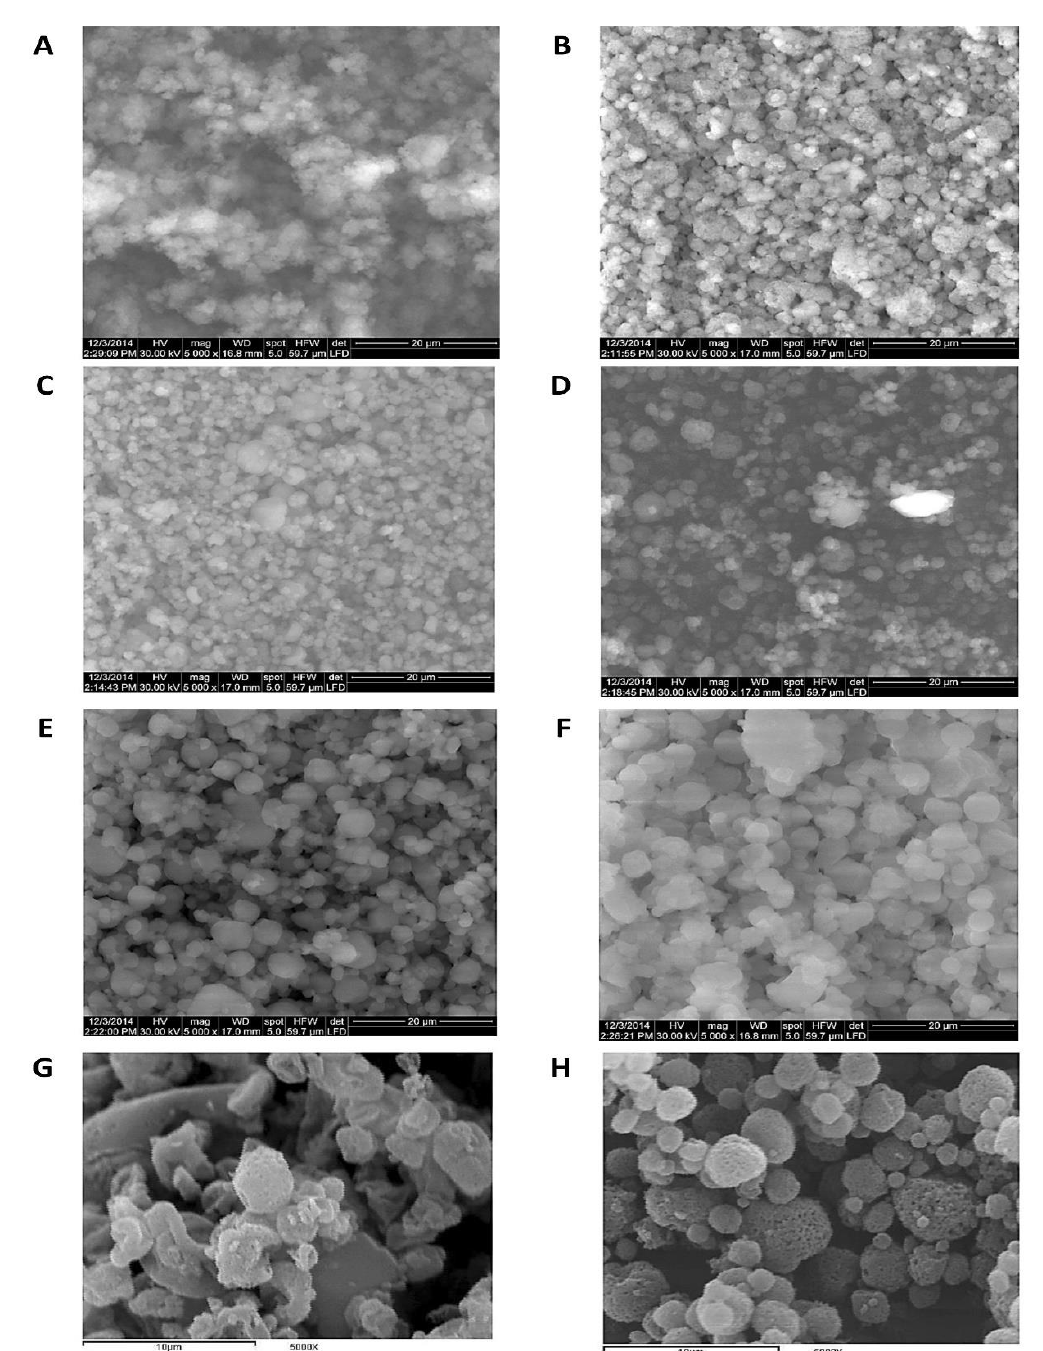
Figure 1. SEM micrographs of different TAA formulations. ( A ) TAA-unprocessed and ( B ) 1%, ( C ) 1.5%, ( D ) 2%, ( E ) 2.5%, and ( F ) 3% ( w / v ) TAA systems spray-dried from 90% ( v / v ) ethanol, ( G ) 1% TAA system spray-dried from 70% ( v / v ) ethanol, and ( H ) 1% TAA system spray-dried from 80% ( v / v ) ethanol.